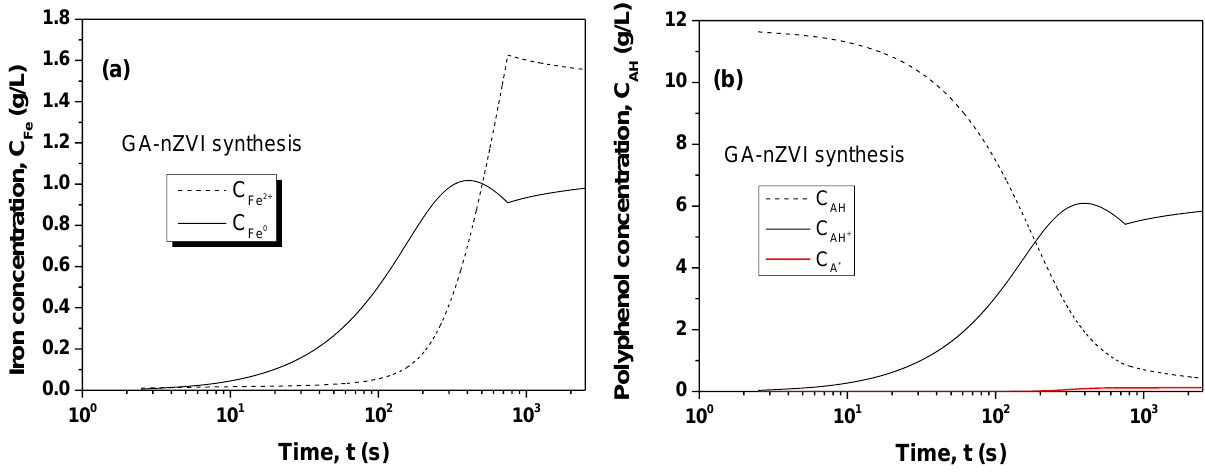
Figure 14. Numerically predicted transient responses of the concentration of (a) iron species, (b) polyphenol species, during the GA-nZVI synthesis